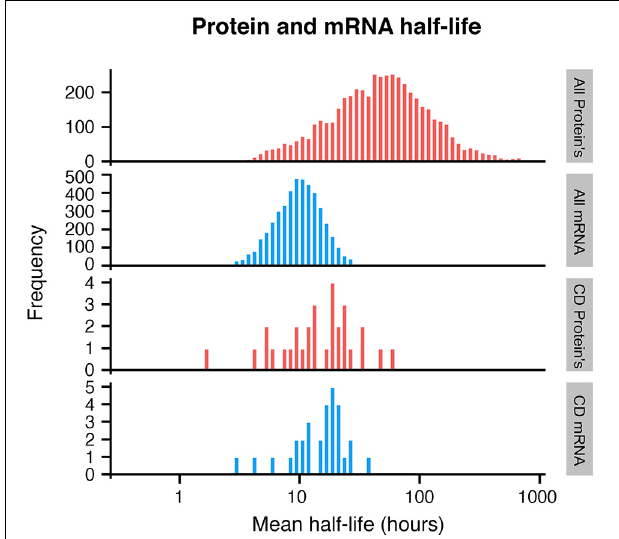
FIGURE 3 | Functional characterization of CD proteins, compared to all other UniProtKB annotated surface proteins based on GO terms. Proteins within the CDome were found to be involved in signal transduction, immune response and adhesion processes to a higher degree than other surface